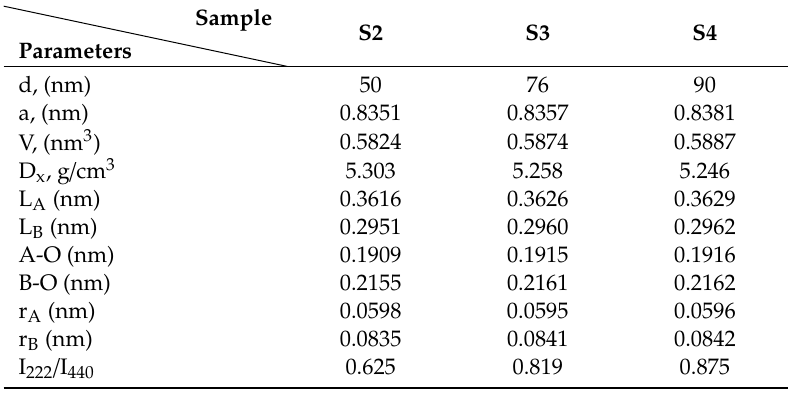
Table 1. Lattice parameters of NiMn 2 O 4 Phase.